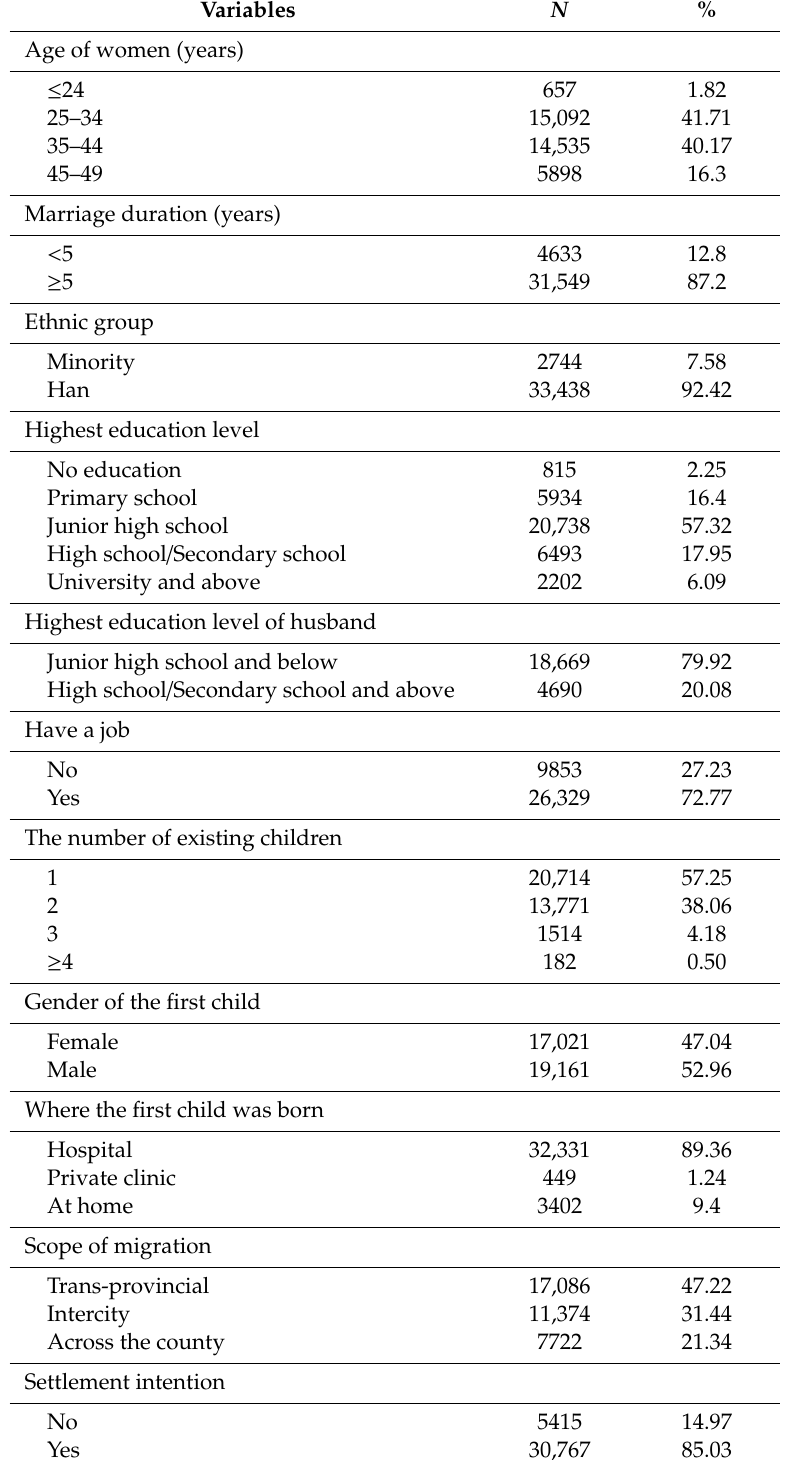
Table 1. Sociodemographic characteristics of the study participants ( N =